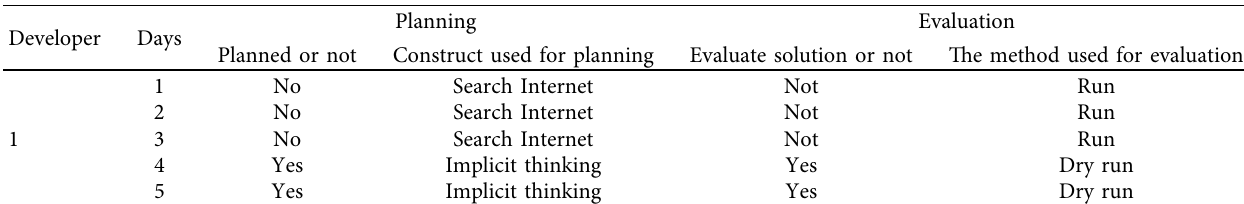
Figure 4: Selected attributes for self-assessment Table 2: Developer planning, monitoring, and evaluation data from the assessment log.